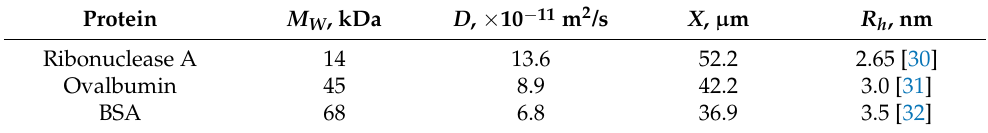
Table 1. Root-mean-square displacement, X , over the time of 10 s for protein macromolecules of various molecular weight, M W , diffusion coefficient, D , and hydrodynamic radius, R h .